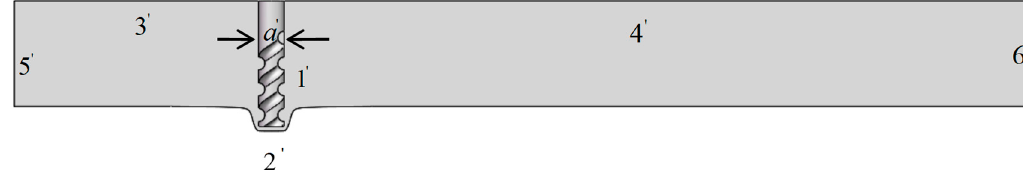
Figure 3. Model of electric field in machining gap.